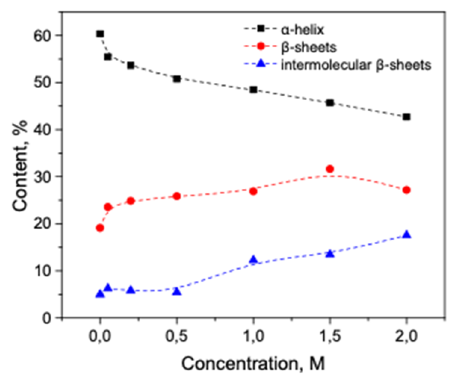
Figure 3. Potassium thiocyanate-induced conformational transition of HSA at 23 °C. Protein concentration was 10% wt.